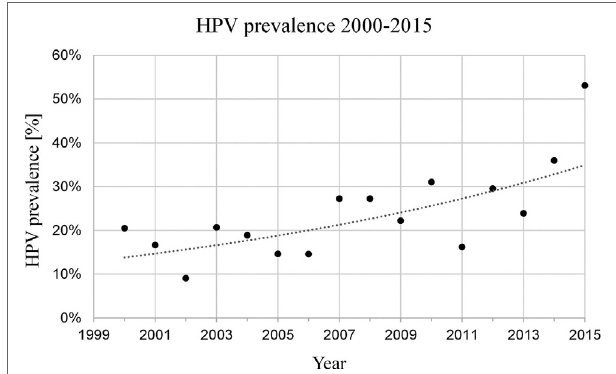
FiGUre 1 | Significant increase in prevalence of human papilloma virus (HPV)-association (21–53%) in oropharyngeal squamous cell carcinoma diagnosed between 2000 and 2015 [ p = 0.002 (Pearson), rho = 0.695 (Spearman)].